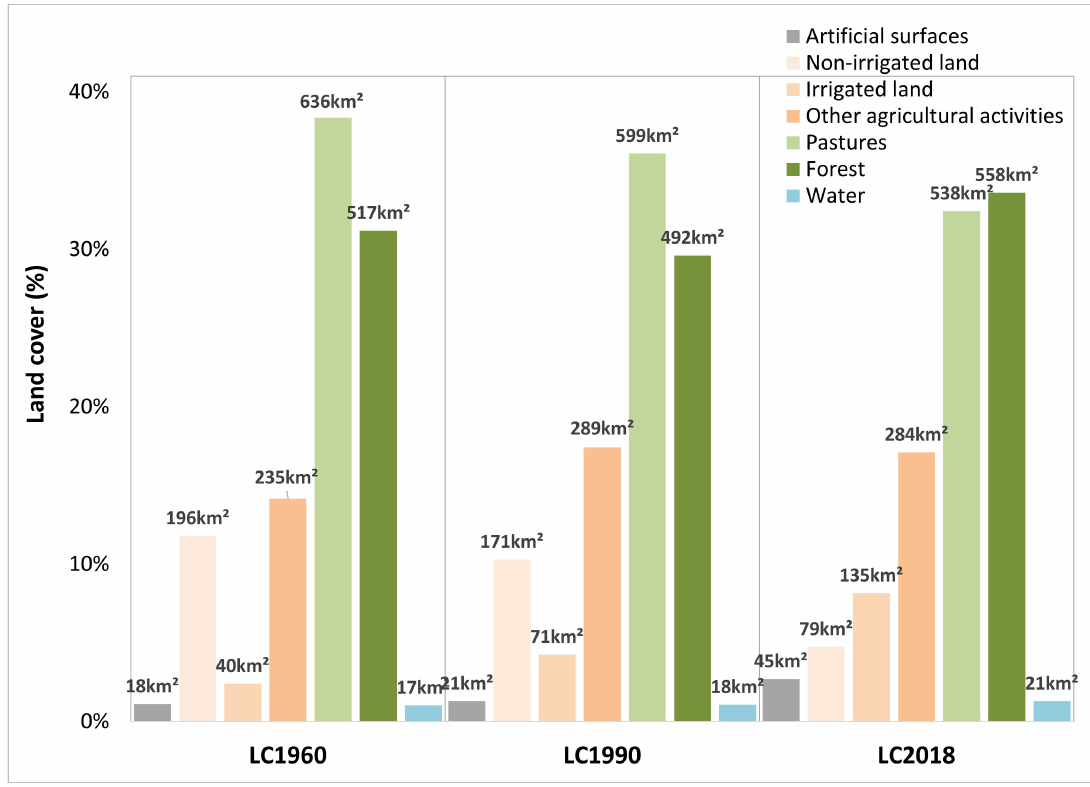
Figure 4. Distribution of land cover type for the three land cover case studies